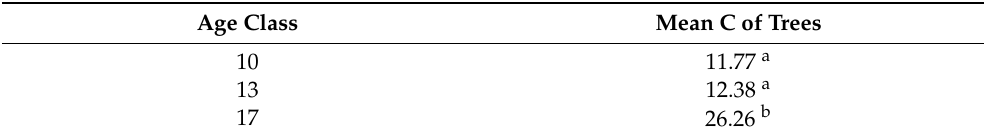
Table 7. Honest Tukey’s significant difference test results for the average amounts of C stored in D. polyphylla trees for three age classes.